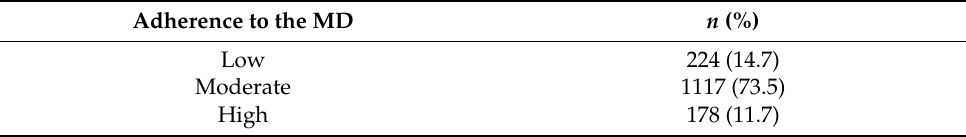
Table 3. Adherence to the Mediterranean Diet